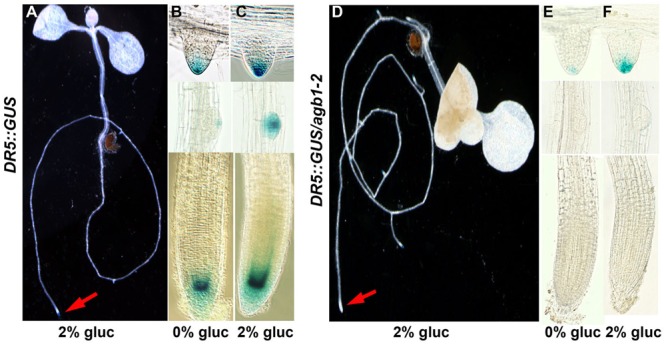
Glucose-induced auxin maxima in agb1-2 mutant roots.
DR5::GUS is a synthetic, auxin-inducible gene promoter reporter used to detect auxin maxima or auxin signaling. (A–C) Wild type and agb1-2 (D–F) seedlings were treated with 2% glucose (gluc) for 4 h (A,C,D,F) and compared to the untreated controls (B,E). Arrows point to the root tip. Compared to wild type, glucose did not increase DR5-driven expression of GUS in the agb1-2 root tips (cf. B,C; lower panels to E,F; lower panels) and lateral root primordial (cf.
B,C; middle panels to E,F; middle panels), although DR5::GUS expression occurred in emergent lateral roots (cf.
B,C; upper panels to E,F; upper panels).